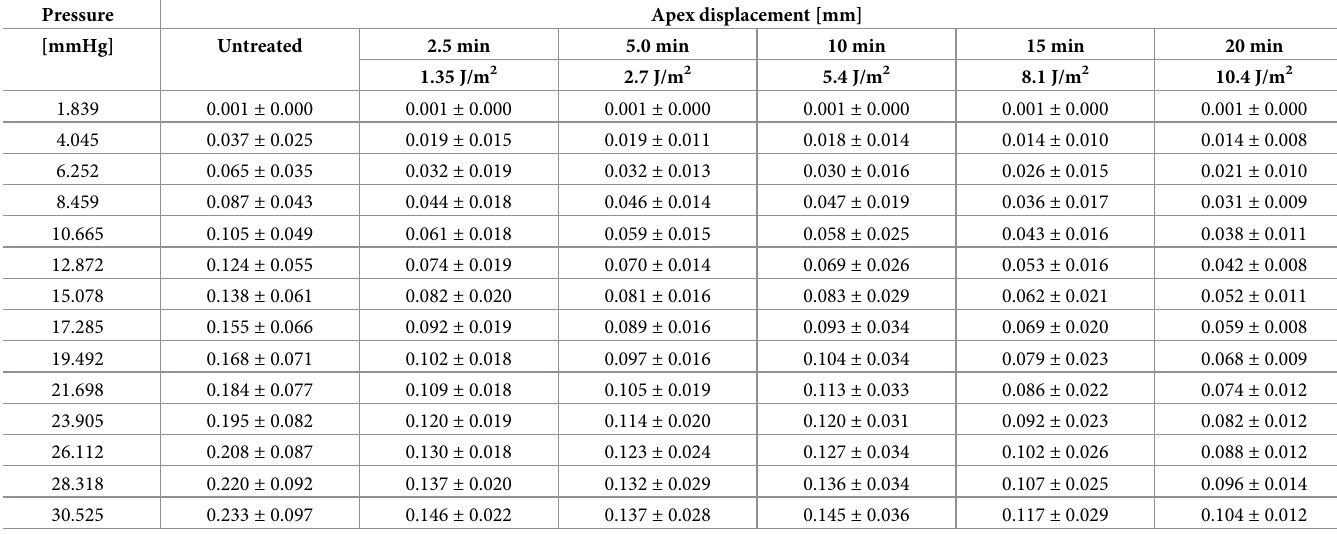
Table 2. Experimental inflation tests.